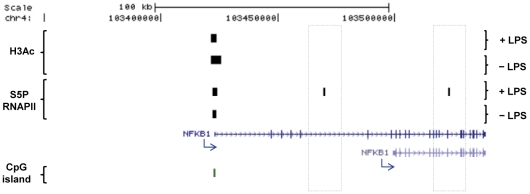
S5P RNAPII ChIP-seq peaks indicate novel alternative promoters and transcription start sites in macrophages upon LPS.
NFKB1 is an example of the identification of a previously unannotated promoter in macrophages after LPS. There is a S5P RNAPII signal for both conditions at the TSS of the large annotated transcript. This TSS also harbours acetylated peaks before and after LPS and high CpG content. Two new S5P RNAPII binding sites (highlighted with a line dots square) appear in response to LPS. These two LPS-induced S5P RNAPII peaks do not colocalize either with regions having H3Ac peaks or high CpG content. Genes identified by RefSeq using the UCSC browser are shown with blue arrows indicating TSSs locations and directions (GRCh37/hg19).